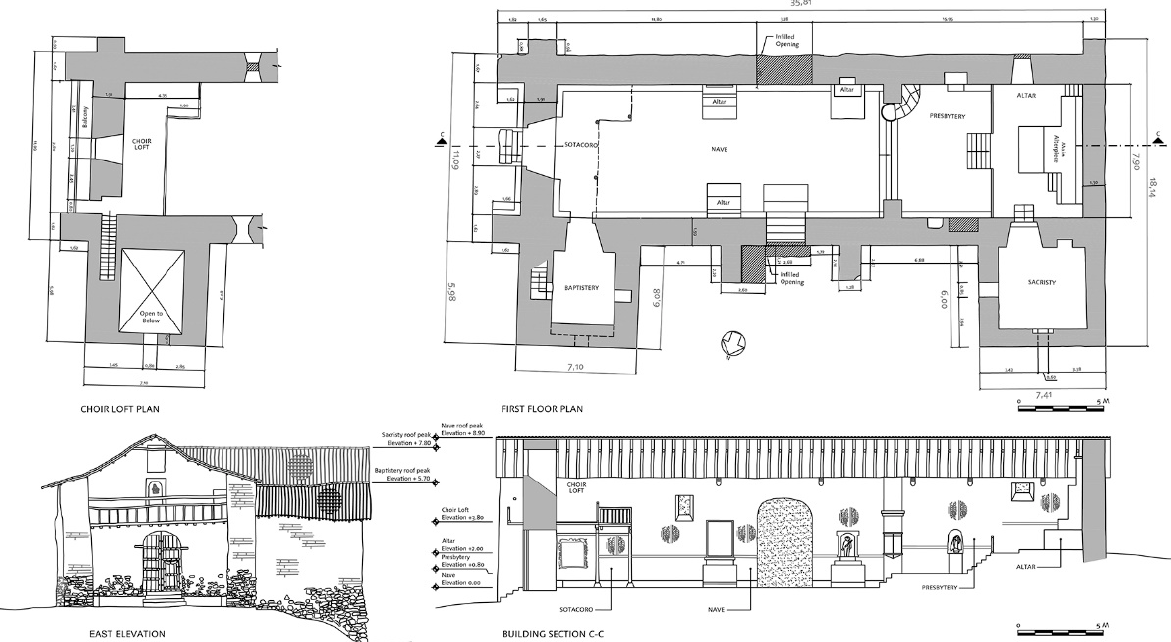
Figure 1. The Church of Kuñotambo: plans at choir loft level and at base floor level, east façade and longitudinal section at nave, presbytery and altar, from 2015, before retrofit [13].